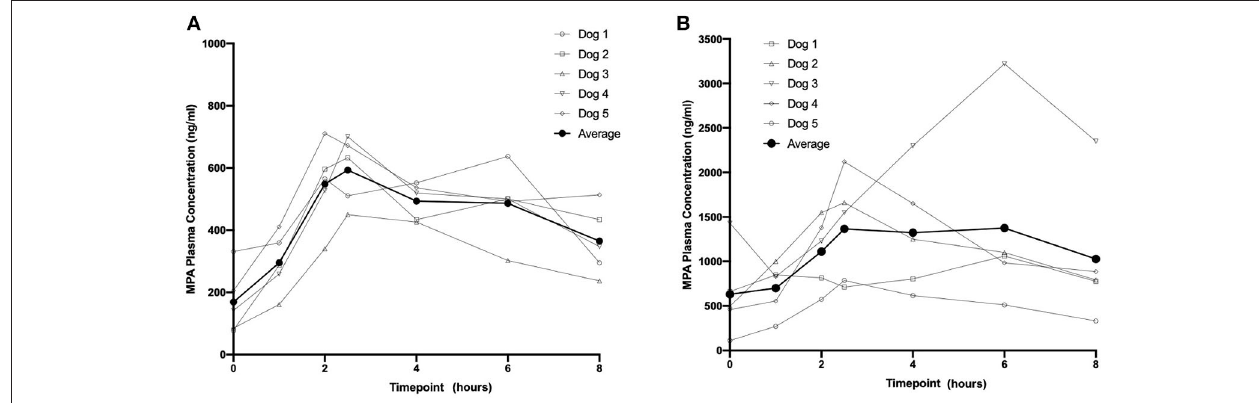
FIGURE 2 | Eight-hour pharmacokinetic profile of OKV-1001b 180mg (A) and 270mg (B) measured following 8 days of drug administration.